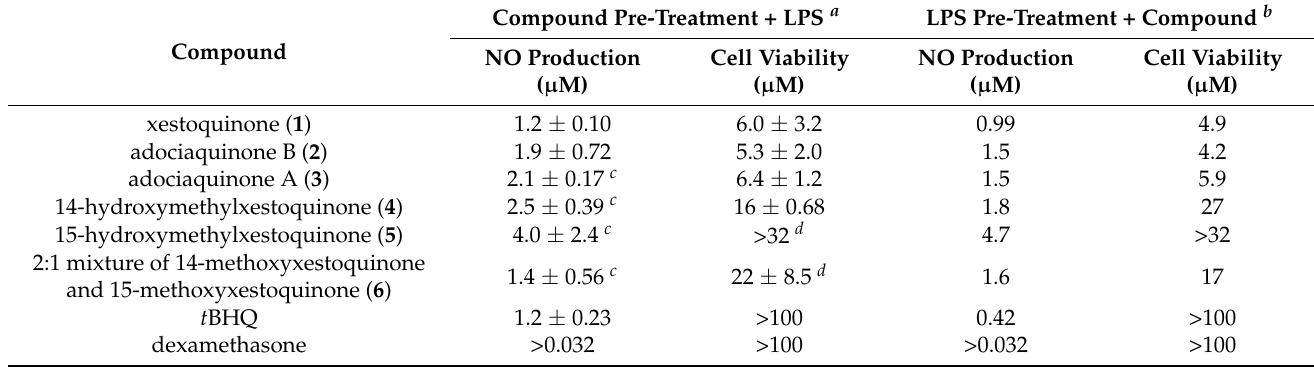
Table 1. Anti-inflammatory activity (IC 50, µ M) and cytotoxicity (IC 50, µ M) of 1 – 6 in